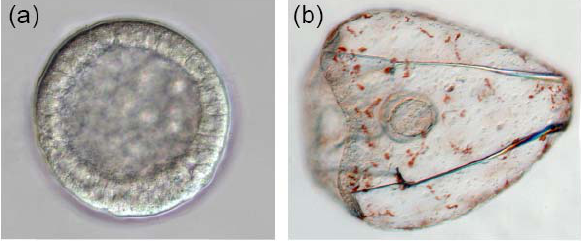
Figure 1. Larval ontogeny of the sea urchin ( Strongylocentrotus purpuratus ), illustrating the developmental emergence of information. (a) 1 day old blastula (~200 cells). (b) 3 day old pluteus (~1000 cells). In contrast to the relatively nondescript blastula, which is essentially a simple hollow ball of ciliated epithelial cells (which however are at this stage molecularly differentiated, representing emergent information that establishes a preformed map of the pluteus body plan), the pluteus has multiple differentiated cell types (e.g., the red pigment cells) and a distinctive bilaterally symmetric anatomy that includes skeletal, digestive, nervous, and immune